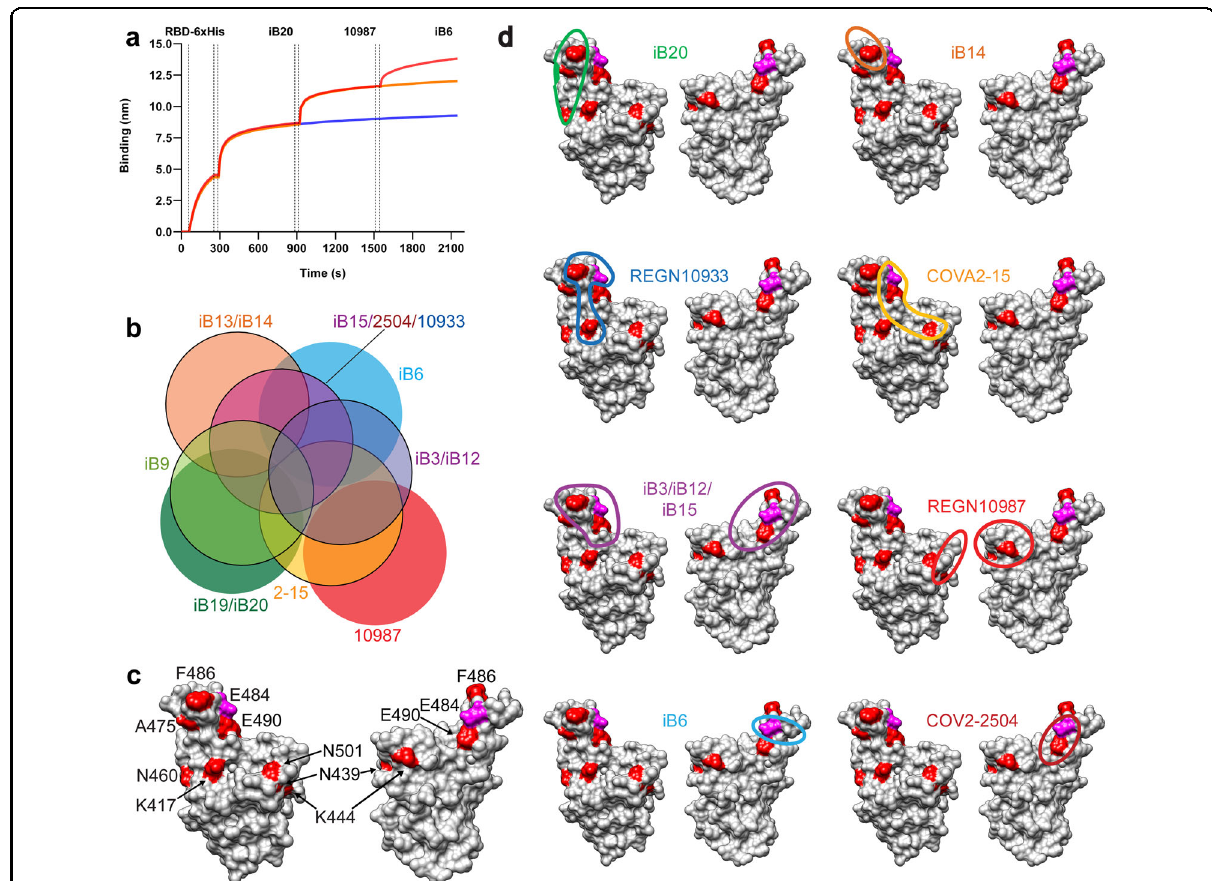
Fig. 4 Epitope binning of SARS-CoV-2 RBD-speci fi c nAbs. The analysis includes either previously published (REGN10987, REGN10933, COVA2-15) or iB-series of nAbs. a BLI analysis of competition between nAbs iB20, REGN10987, and iB6 for RBD binding. b Venn diagram showing mutual overlap between the tentative epitopes of nAbs forming eight distinct bins. The diagram was plotted based on the BLI data (Supplementary Figs. S6 and S7). c Positions of nine mutations escaping neutralization by at least one of the tested antibodies. Residues mutated are highlighted red or pink on the 3D model of SARS-CoV-2 RBD. d Tentative positions of nAb footprints are